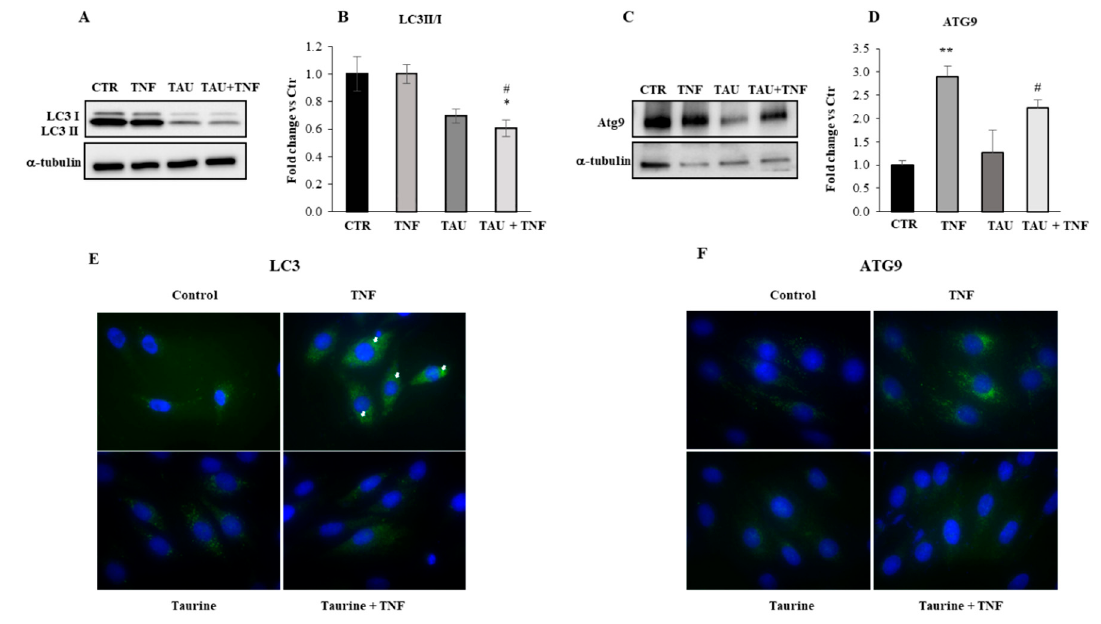
Figure 4. Taurine downregulates the TNF-dependent expression of autophagic markers. ( A , C ) Western blot analyses of total lysates were achieved to evaluate the expression levels of LC3 and Atg9 in relation to the treatments indicated in the Figure. ( B , D ) The graphs show the densitometric analyses performed by using anti- α -tubulin antibody to verify the loading of the samples. Representative blots are shown. Statistical analysis was performed by Student’s t -test. * p < 0.05; ** p < 0.01; * vs Control, # vs TNF. ( E,F ) Immunofluorescence analysis was performed to evaluate the expression levels and cellular localization of LC3 (head arrows indicate LC3 puncta) and Atg9 (original magnification × 20).